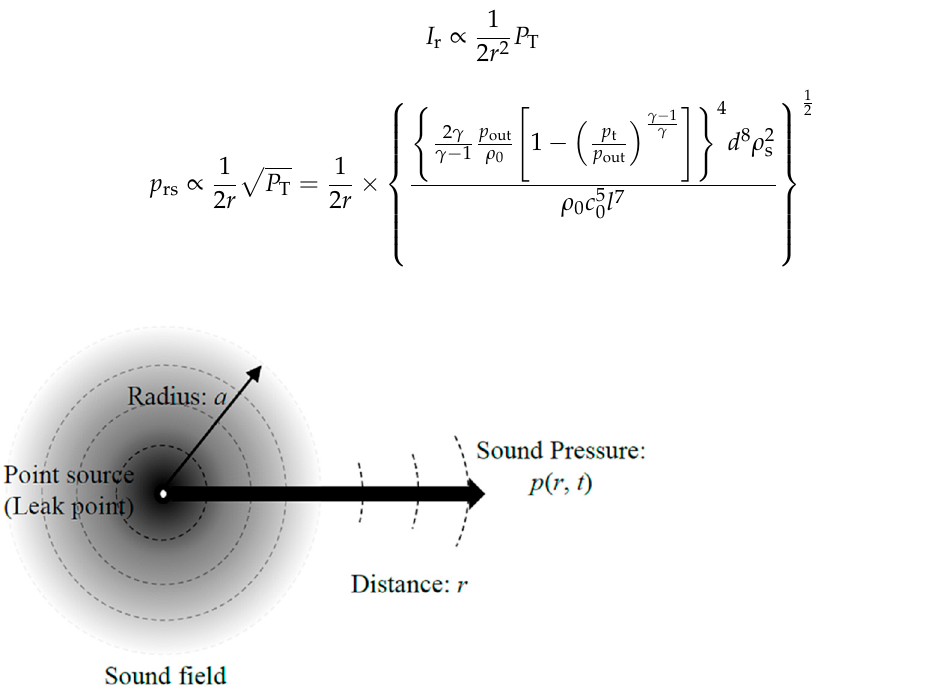
Figure 3. Schematic diagram of the transmission of point source sound field.